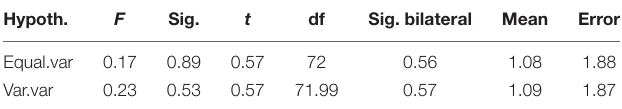
TABLE 2 | Independent sample testing (previous test). Hypoth.